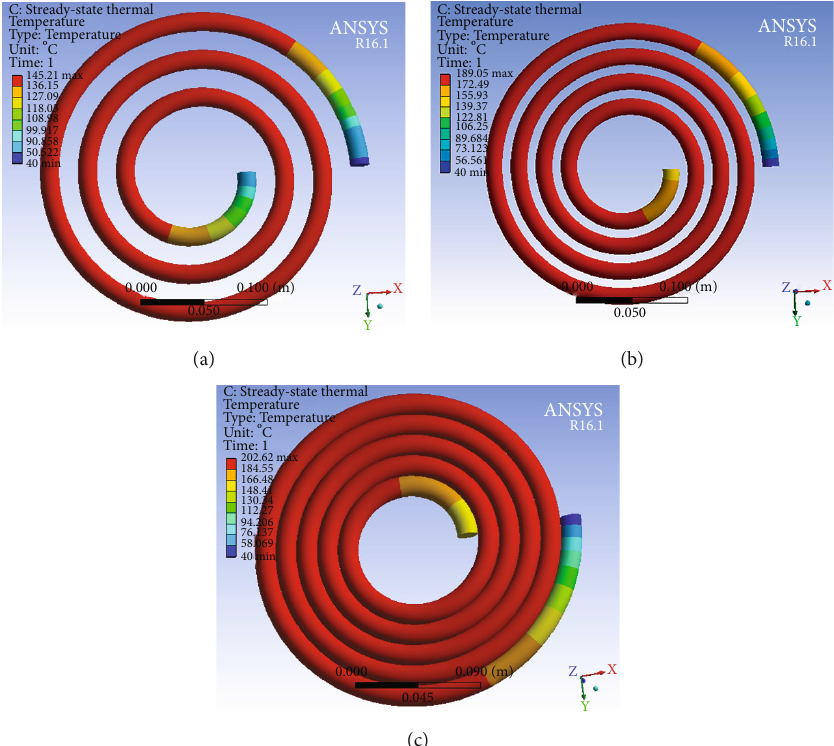
Figure 6: Temperature distribution through (a) three convolutions of coil, (b) four convolutions of coil, and (c) fi ve convolutions of coil.